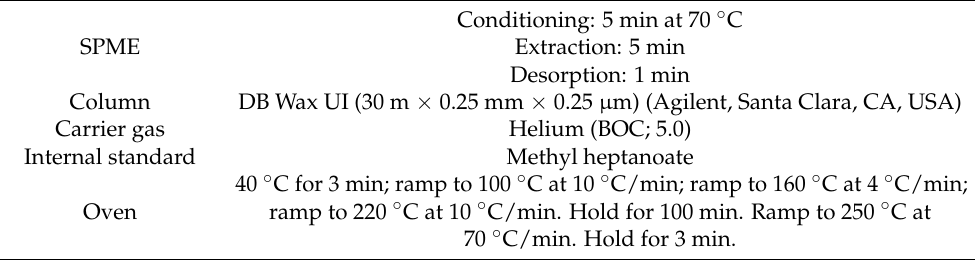
Table 2. GC/MS Instrument